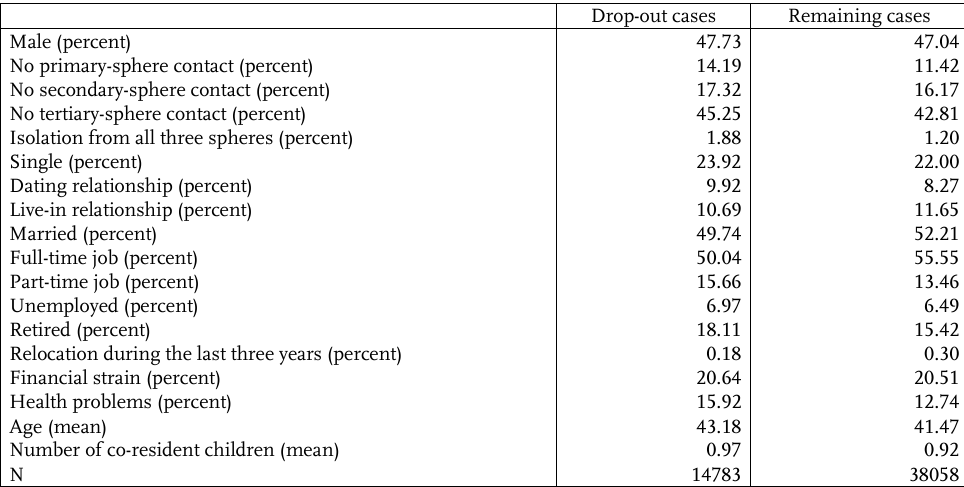
Table A.1 : Distribution of key-variables among drop-out cases and cases remaining in the sample